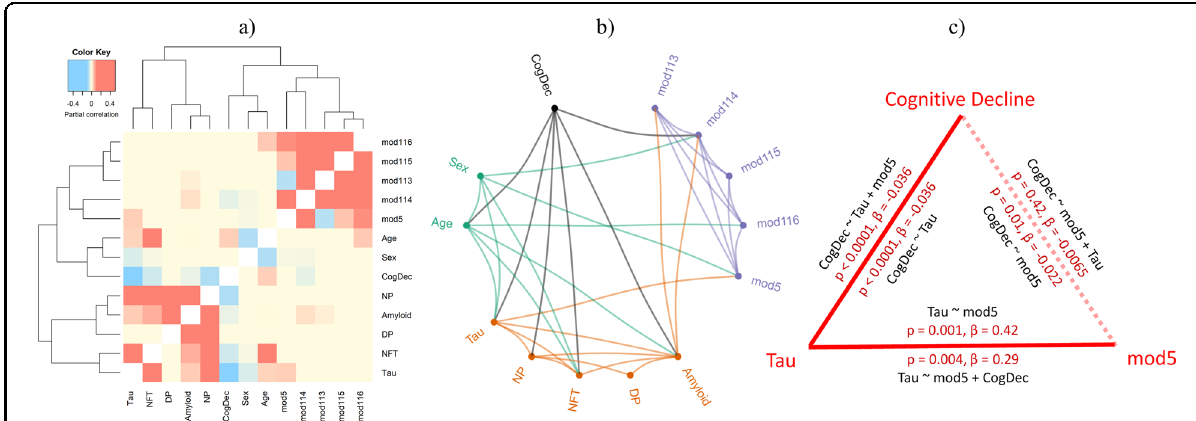
Fig. 2 Relationships between gene modules and Alzheimer ’ s disease traits. The conditional dependencies between the expression level of modules and Alzheimer ’ s disease traits in the 540 ROSMAP participants are illustrated in ( a ) a heatmap and ( b ) a network diagram. In ( b ), a module or a trait is considered to be a node in the network, and these nodes are connected by lines (edges) if there is evidence that they are associated, after accounting for the behavior of all other modules and traits using partial correlation analysis. c Graphical summary of mediation analyses which propose that m5 increased expression precedes the accumulation of Tau which then leads to cognitive decline. All three factors are correlated to one another. On the inner aspect of each edge, we report the P value and effect size of the direct association of two traits, which are listed. The outer aspect of each edge presents the results of the model with the third variable included. The dotted edge denotes the fact that the association of m5 and cognitive decline is no longer signi fi cant once we adjust for the burden of Tau pathology. This suggests the order of events as being m5 → Tau → cognitive decline. All regression models also include RIN and PMI. mod module, CogDec cognitive decline, NP neuritic plaques, DP diffuse plaques, NFT neuro fi brillary tangles, RIN RNA integrity